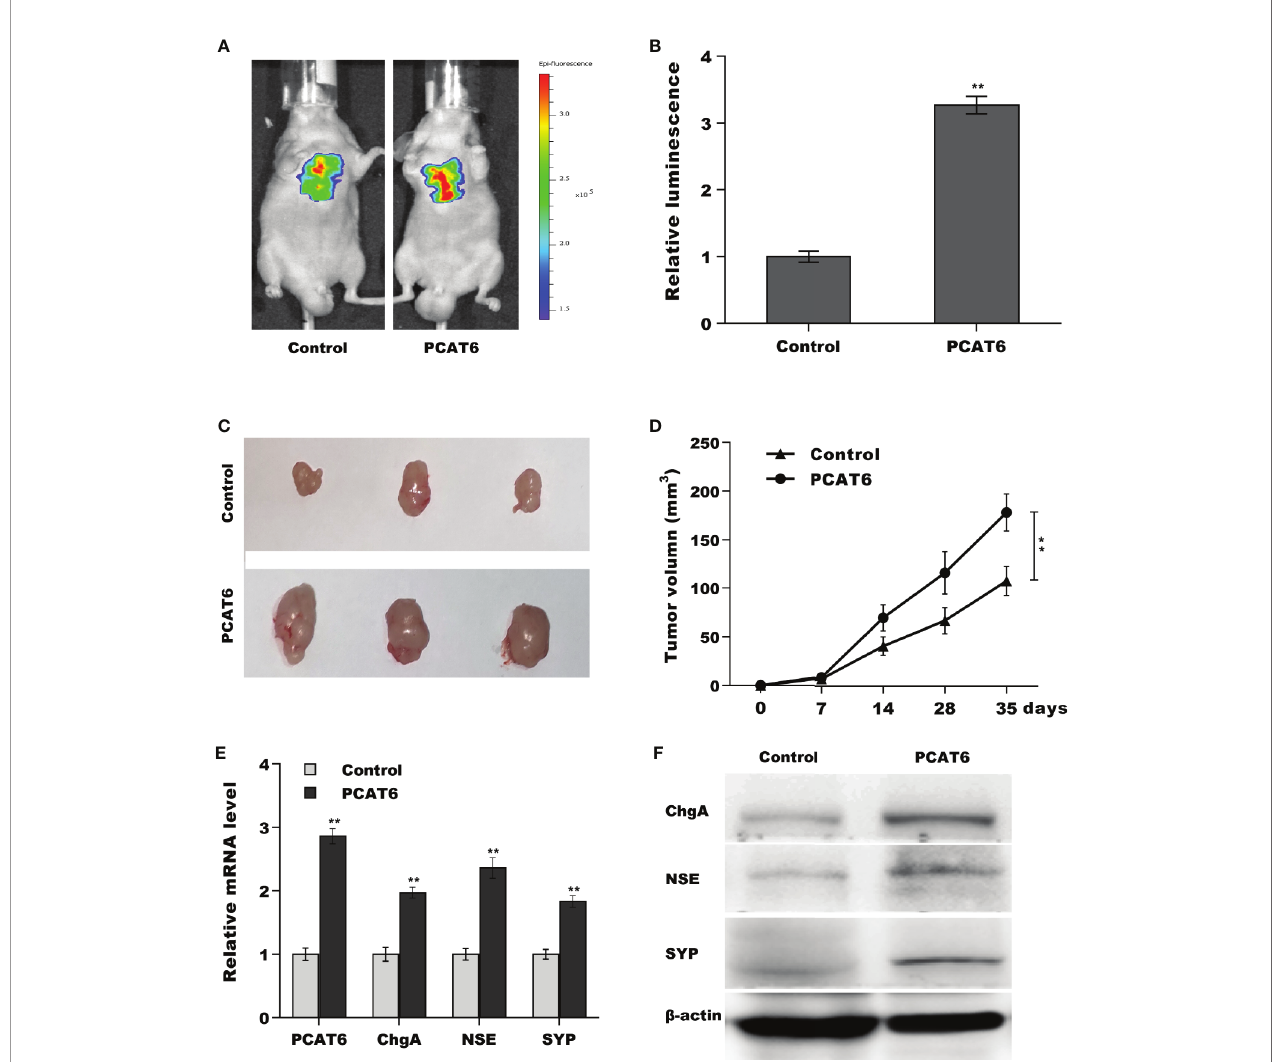
FIGURE 3 | PCAT6 promoted PCa growth and metastasis in vivo . (A, B) Cancer metastasis was assayed using bioluminescent imaging after PCAT6- overexpressed. (C, D) LNCaP cells stably expressed with PCAT6 were injected intravenously into the tail vein of male nude mice and tumor volume was calculated at the different time points (7, 14, 28, 35 days). (E) qPCR analysis of PCAT6, NSE, SYP, and ChgA mRNA expression in LNCaP cells after PCAT6 overexpression. (F) Western blot analysis for NSE, SYP, and ChgA protein level in LNCaP cells after PCAT6 overexpression. ** p